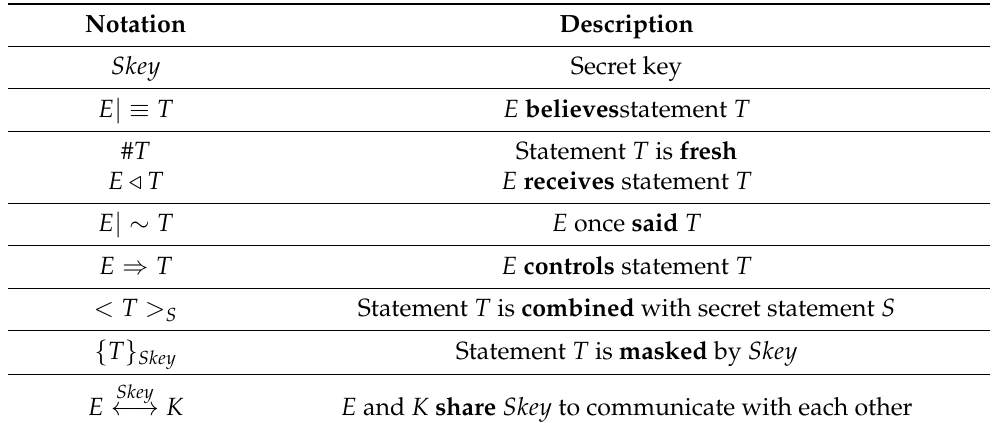
Table 1. BAN Logic